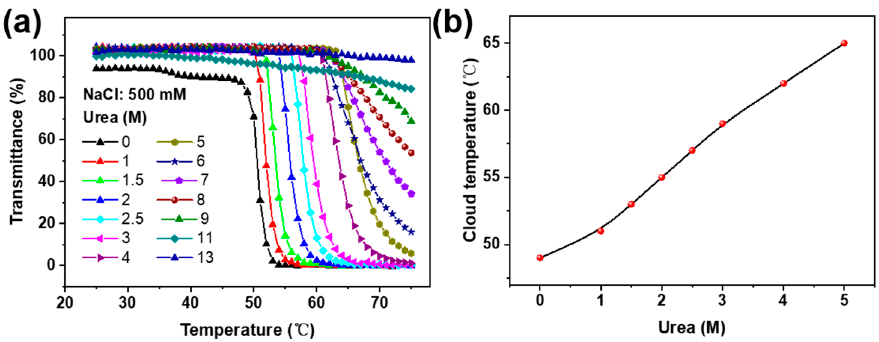
Figure 4. ( a ) Effect of urea concentration on the thermal response of P2 in NaCl aqueous solution. ( b ) Plots of the cloud-point temperature versus urea concentration in NaCl solution.